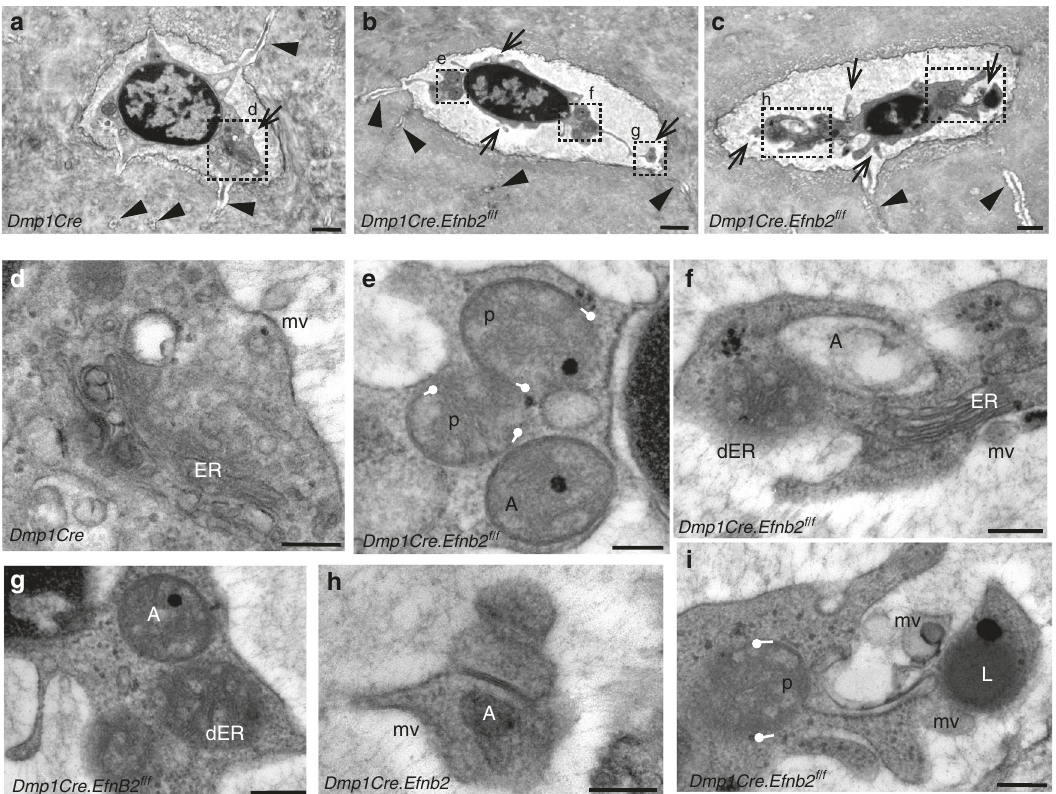
Fig. 6 Transmission electron microscopy of bone-embedded osteocytes in Dmp1Cre ( a , d ) and Dmp1Cre.Efnb2 f/f ( b , c , e – i ) mice. a – c Low power images, showing typical osteocyte morphology in control Dmp1Cre bone ( a ) and in Dmp1Cre.Efnb2 f/f bone ( b , c ). Dmp1Cre.Efnb2 f/f osteocytes are grossly abnormal, showing contraction from the lacuna, extensive ruf fl ing, and formation of matrix vesicles (arrows), but normal appearance of dendritic processes within the canaliculi (arrowheads); boxes show regions magni fi ed in d – i . d Cytoplasm of a control Dmp1Cre osteocyte, showing a budding matrix vesicle (mv), and endoplasmic reticulum (ER) within the cytoplasm. e – i Features of Dmp1Cre.Efnb2 f/f osteocytes, including autophagomes (A) and lysosomes (L). Autophagosomes are either fully enclosed ( e – h ) or exhibit phagophores (p) in the process of encapsulating their cargo, which has the appearance of degraded ER ( e , f , i ); phagophores in the process of formation are delineated with white lollipops at the tips of the membrane with sticks facing the direction of the formed membrane. Functioning ER is also observed ( f ), along with unencapsulated degraded ER (dER), and many matrix vesicles (mv) in various stages of budding ( f – i ). Scale bars a – c = 1 μ m, d – i = 250